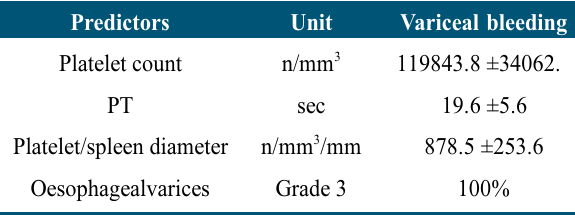
Table 5: Predictors of variceal bleeding